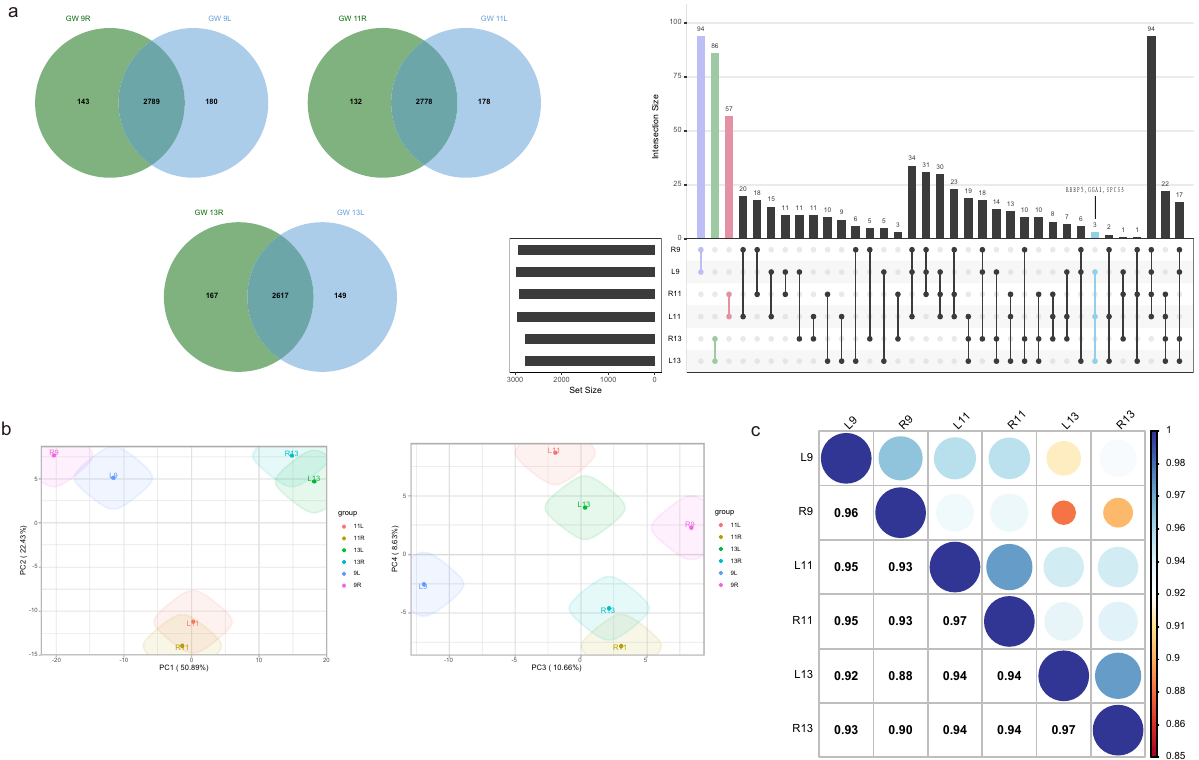
Fig. 2 Proteomes of the left and right fetal frontal lobes. a Overlapping proteins in the bilateral frontal lobes at each gestational week. An UpSetR diagram was created to visualize the proteins identi fi ed in only one gestational week. Three proteins only detected in the left side of the frontal lobe are listed in the fi gure. b PCA plots of PC1 versus PC2, and PC3 versus PC4. The fi rst four principal components account for 92.61% of the total data variance, and the individual contributions of PC1, PC2, PC3, and PC4 are 50.89%, 22.43%, 10.66% and 8.63%, respectively. c Pearson correlation analysis of samples from different gestational